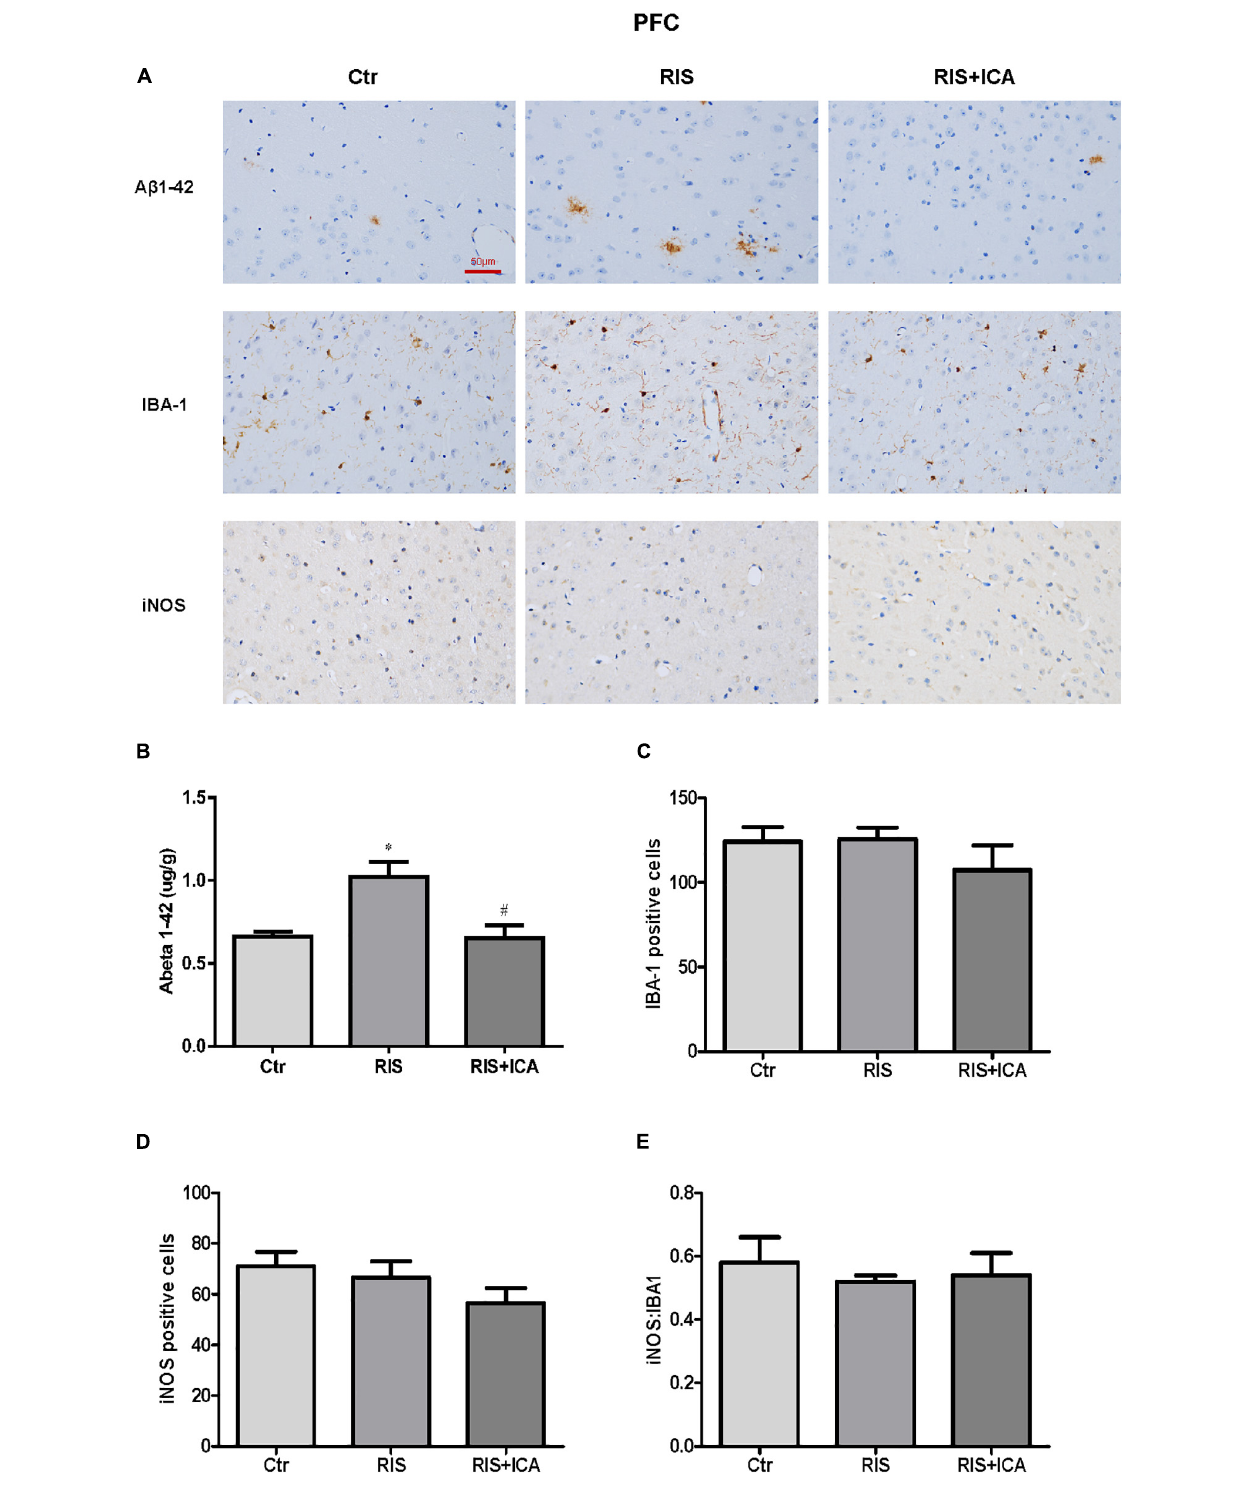
FIGURE 7 | Effect of icariin on A β plaques and microglia phenotype in the PFC. (A) Results of immunohistochemical staining (400 × ). (B) RIS significantly increased the level of A β compared with controls, and icariin decreased it. (C–E) The number of Iba-1+ (C) and iNOS+ (D) microglia cells was not significantly different among the three groups. As a result, the ratio of iNOS+ to Iba-1+ microglia (E) was not significantly different either among the three groups. The results of A β are expressed as the mean ± SEM, n = 6; the results of Iba-1 and iNOS are expressed as the mean ± SEM, n = 4. ∗ p < 0.05 vs. control group; # p < 0.05 vs. RIS group.